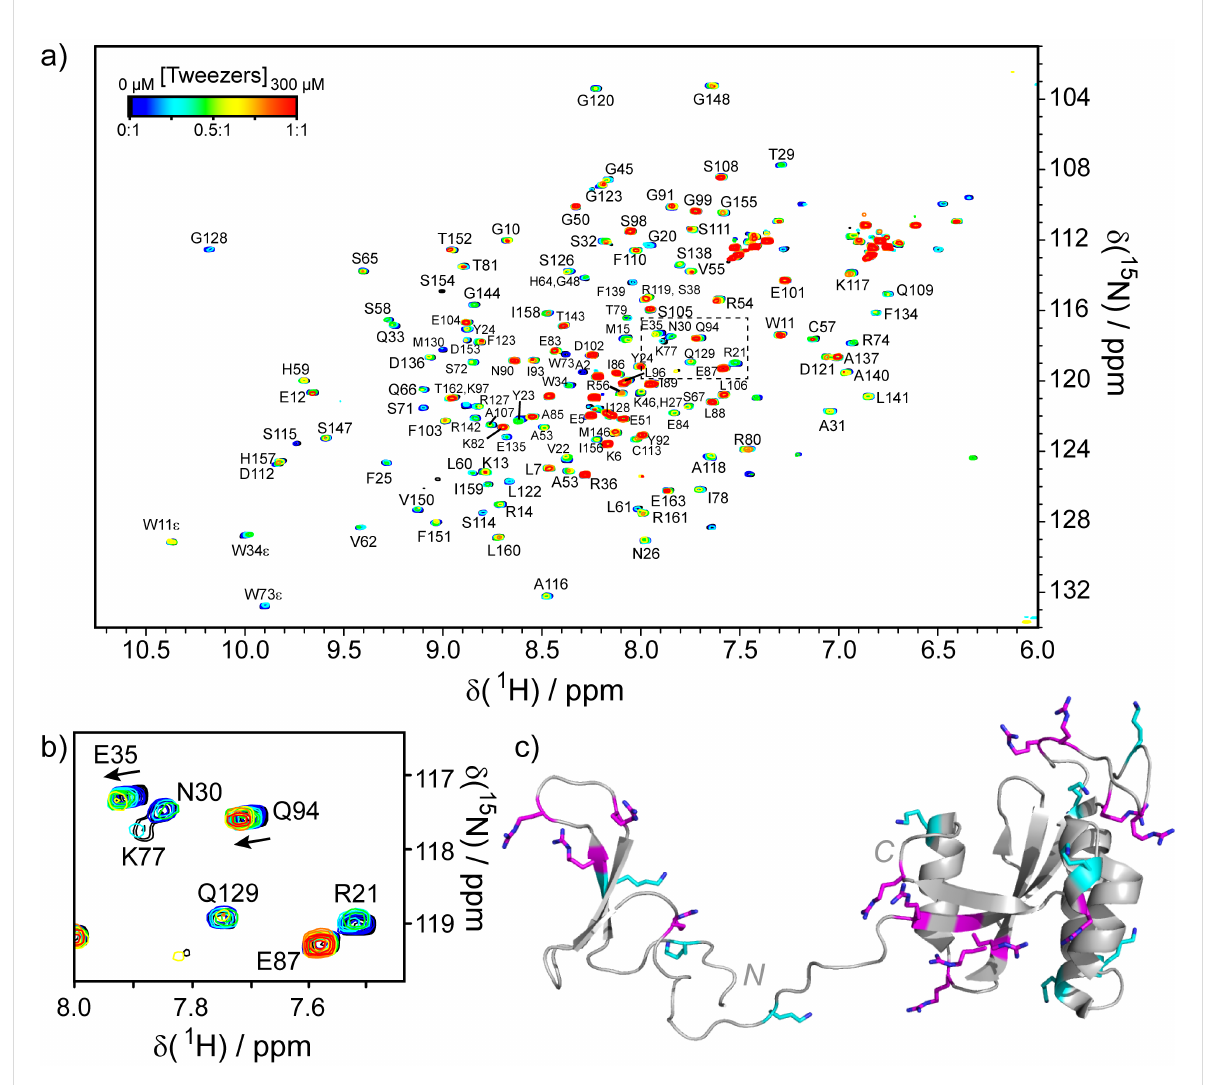
Figure 3: 1 H, 15 N-HSQC Titration of full-length h Pin1 with supramolecular tweezers (original data). (a) Spectra for different tweezer concentrations are overlaid and color-coded. Ligand binding causes a concentration-dependent shifting and/or broadening of the signals. At a 1:1 ratio of ligand to pro- tein (red spectrum), many signals broaden. This can indicate the formation of soluble aggregates. (b) The expansion shows the area marked by the dashed box. Residue Q94 experiences a shifting of the signal upon tweezer binding (chemical shift perturbation). Residues R21, N30, K77 and Q129 show strong line broadening due to chemical exchange, which leads to a vanishing of the signals at low tweezer concentrations. Residue E35 shows both chemical shift perturbation and line broadening. Residue E87 is not affected by tweezers. (c) NMR Structure of h Pin1 (pdb 1NMV, [75]) with lysines highlighted in cyan and arginines highlighted in